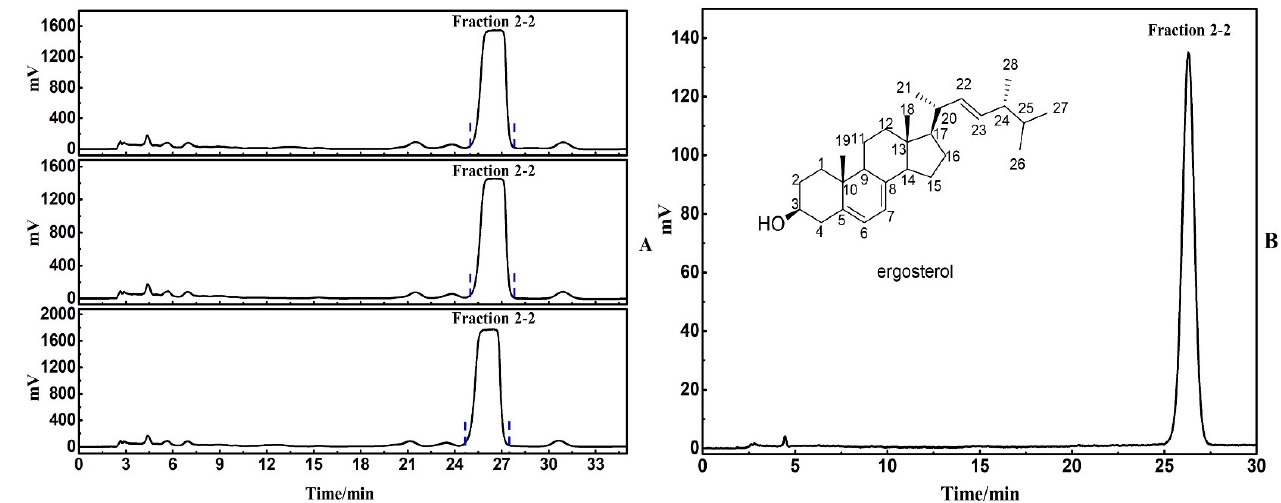
Figure 4. The preparative chromatogram and HPLC purity assay of the target fraction on ReproSil C18 analytical column in methanol/water ( A ). Conditions: mobile phase water and methanol; isocratic elution: 0–35 min, 100% methanol; monitoring wavelength: 270 nm; flow rate: 1.0 mL/min; injection volume of the preparative chromatogram: 80.0 μ L; injection volume of HPLC purity assay: 1.0 μ L; column temperature: 30 °C. The purity of the isolated compound was examined using a ReproSil-Pur C18 AQ analytical column ( B ). The isocratic elution procedure was 100% methanol for